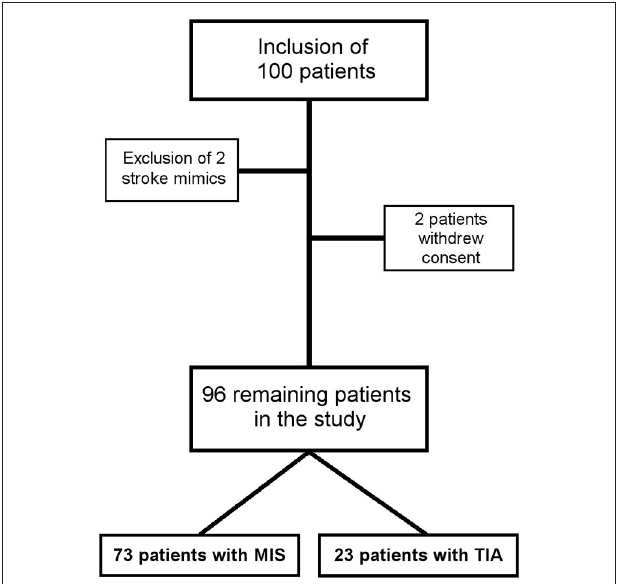
FIGURE 2 | Flow chart for the study. Minor ischemic stroke MIS, transient ischemic attack TIA.